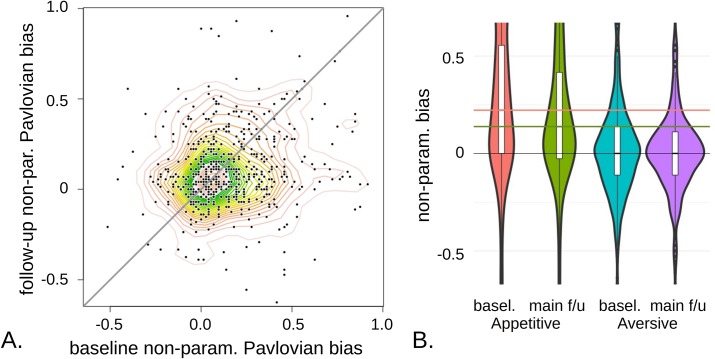
Stability in descriptive estimates of Pavlovian bias, assessed by the interaction between the fractions of total correct answers in the four conditions, ((G2W-NG2W)+(NG2AL-G2AL))/2.A. Stability assessed by baseline vs. long follow-up estimates. A positive correlation is detectable, rho~0.15, p = 5.4e-4. B. Difference in performance between the appetitive (two left) and aversive (two right) conditions. The horizontal lines show the median appetitive bias at baseline (G2W-NG2W; first violin plot; salmon) vs. long follow-up (second plot, in green). This significant difference (p = 0.0027) drives an overall reduction in the estimate of Pavlovian bias (p = 0.0019). The aversive context, NG2AL-G2AL, shows no significant change on its own (blue and mauve; p = 0.35). White boxes are interquartile ranges.